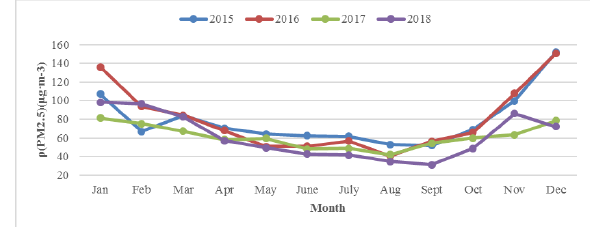
Figure 3. Monthly PM2.5 concentration in “2+26” cities